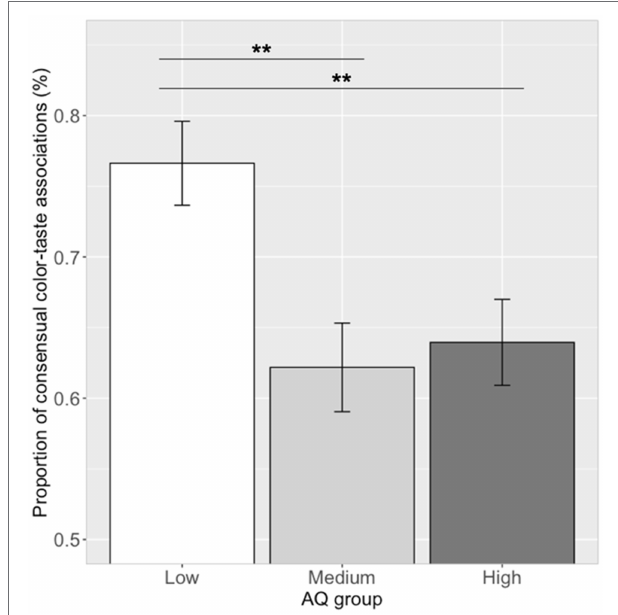
FIGURE 4 | Proportion of consensual color–taste associations in the three AQ groups. Error bar represents the standard mean error. Asterisks indicate significant differences (** p <